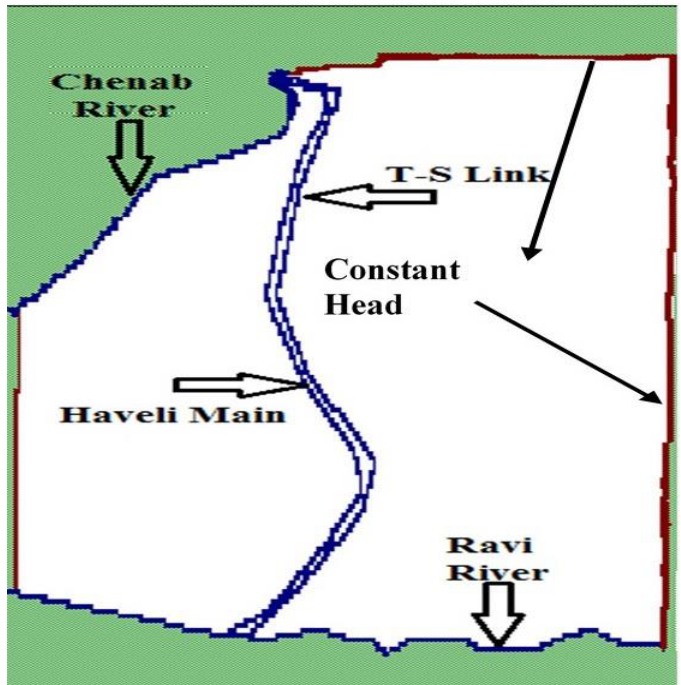
Figure 2. Model Grid Layout.